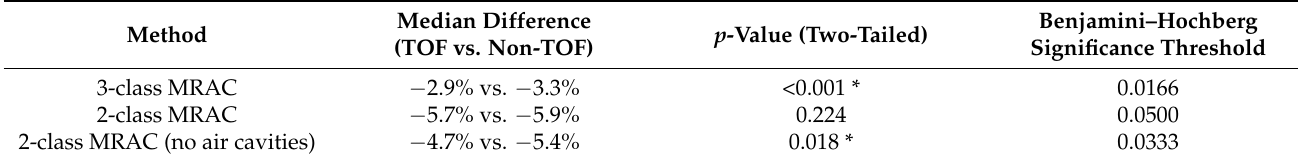
Table 2. Results of the Wilcoxon’s signed rank test. Median difference denotes the median of average VOI errors in TOF vs. non-TOF reconstructions. The significance thresholds of the Benjamini– Hochberg method are given, and statistically significant p -values are denoted with *.